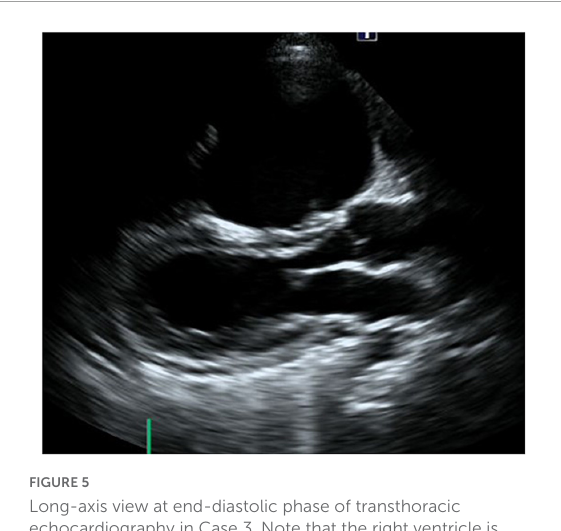
FIGURE7 Short-axis view at end-diastolic phase of transthoracic echocardiography in Case 4.